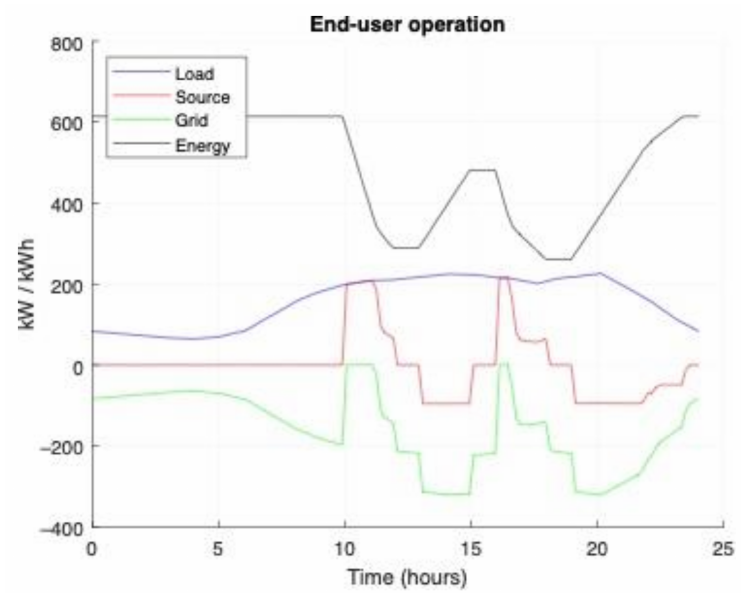
Figure 8. End-users’ power and energy behavior in the scenario of Section 7.5a. End-users are equipped with energy storage units rated to feed the local load power for about two hours. Cost of energy is assumed to increase by 50% in the interval 10–12 a.m. and 3–4 p.m., and to halve during